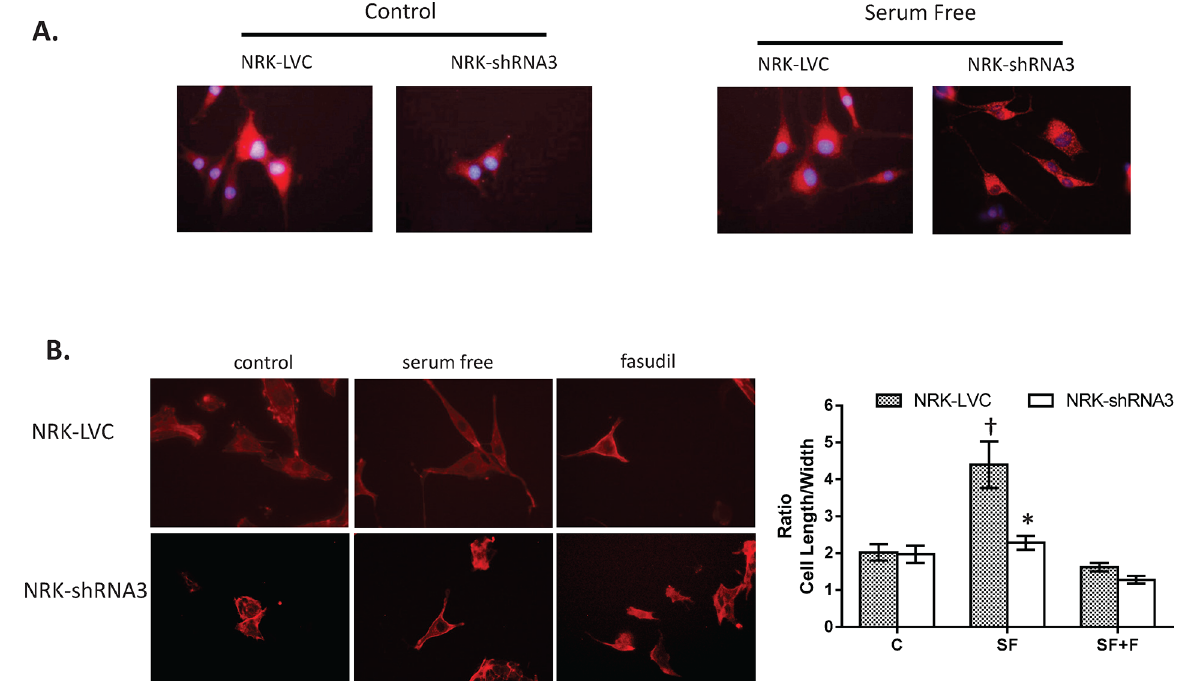
Fig 5. ARHGEF11 localization and actin (F-actin) cytoskeleton immunofluorescence. ( A ) Localization of ARHGEF11 in stably transduced NRK cells [-LVC (lentiviral scramble control) or – shRNA3]. ARHGEF11 is located near the nucleus and throughout the cell under control conditions for both LVC and LVC-shRNA3 cells, Under serum free conditions ARHGEF11 appears to be distributed throughout the cell and toward the cell membrane. ( B ) Immunofluorescence of F-actin in stably transduced NRK cells under control, serum free and fasudil treatment. Cells cultured under serum free conditions develop stress fibers and demonstrate elongation of cells. NRK-shRNA3 cells demonstrate a significant reduction in stress fibers, similar to pharmacological imbibition of ROCK by fasudil, as cell length/width ratio decreases to baseline with genetic knockdown of Arhgef11 . * p < 0.05, n = 3 independent samples/20 random images per slide (6 – 10 cells per view). Error bars are ±